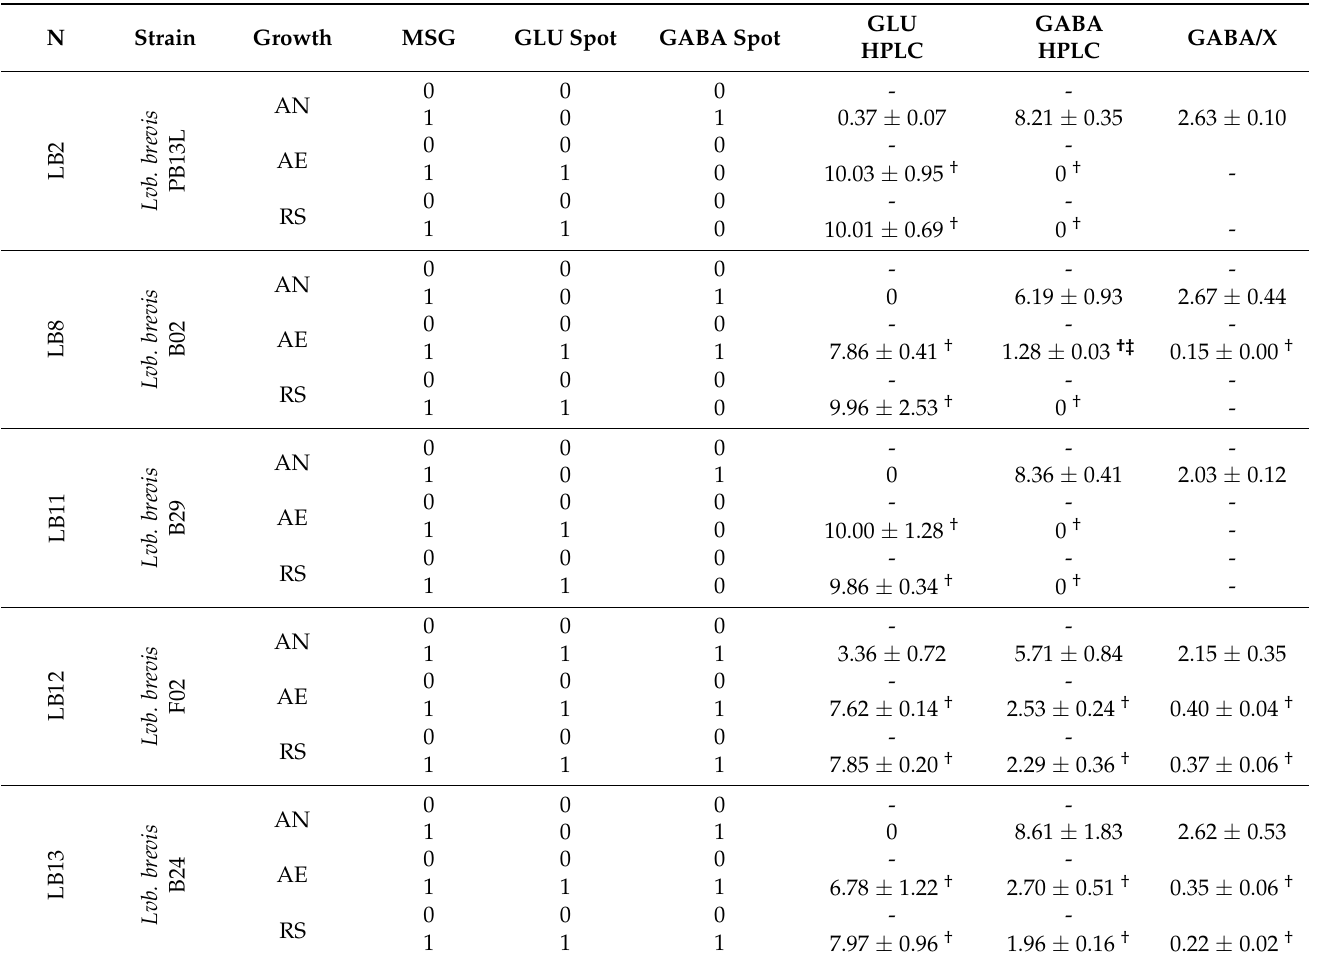
Table 2. The production of γ -aminobutyric acid in Levilactobacillus brevis strains cultivated under anaerobic, aerobic, and respiratory conditions, with or without glutamate